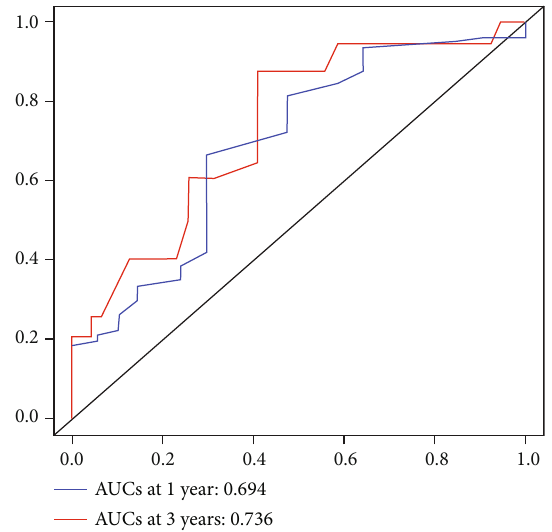
Figure 3: Calibration curve showing a good fi tting of the predicted and observed survival.